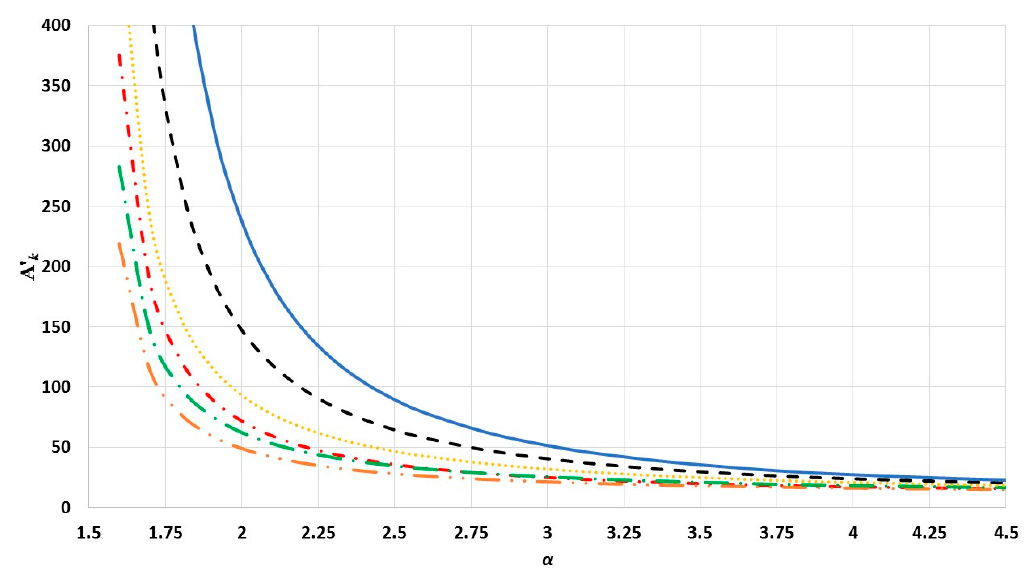
Figure 3. The variation of (cid:1827)′ (cid:3038) ((cid:1870) (cid:2868)∗ ) for a face-centered cubic metal with the (cid:2009) parameter for (cid:1865) = 3 , where the blue solid line represents (cid:1827)′ (cid:2874) ((cid:1870) (cid:2868)∗ ) , the black dashed line represents (cid:1827)′ (cid:2873) ((cid:1870) (cid:2868)∗ ) , the yellow dotted line represents (cid:1827)′ (cid:2872) ((cid:1870) (cid:2868)∗ ) , the green long-dashed-dotted line represents (cid:1827)′ (cid:2871) ((cid:1870) (cid:2868)∗ ) , the orange dashed-dotted-dotted line represents (cid:1827)′ (cid:2870) ((cid:1870) (cid:2868)∗ ) , and the red dashed-dotted line represents (cid:1827)′ (cid:2869) ((cid:1870) (cid:2868)∗ ) .